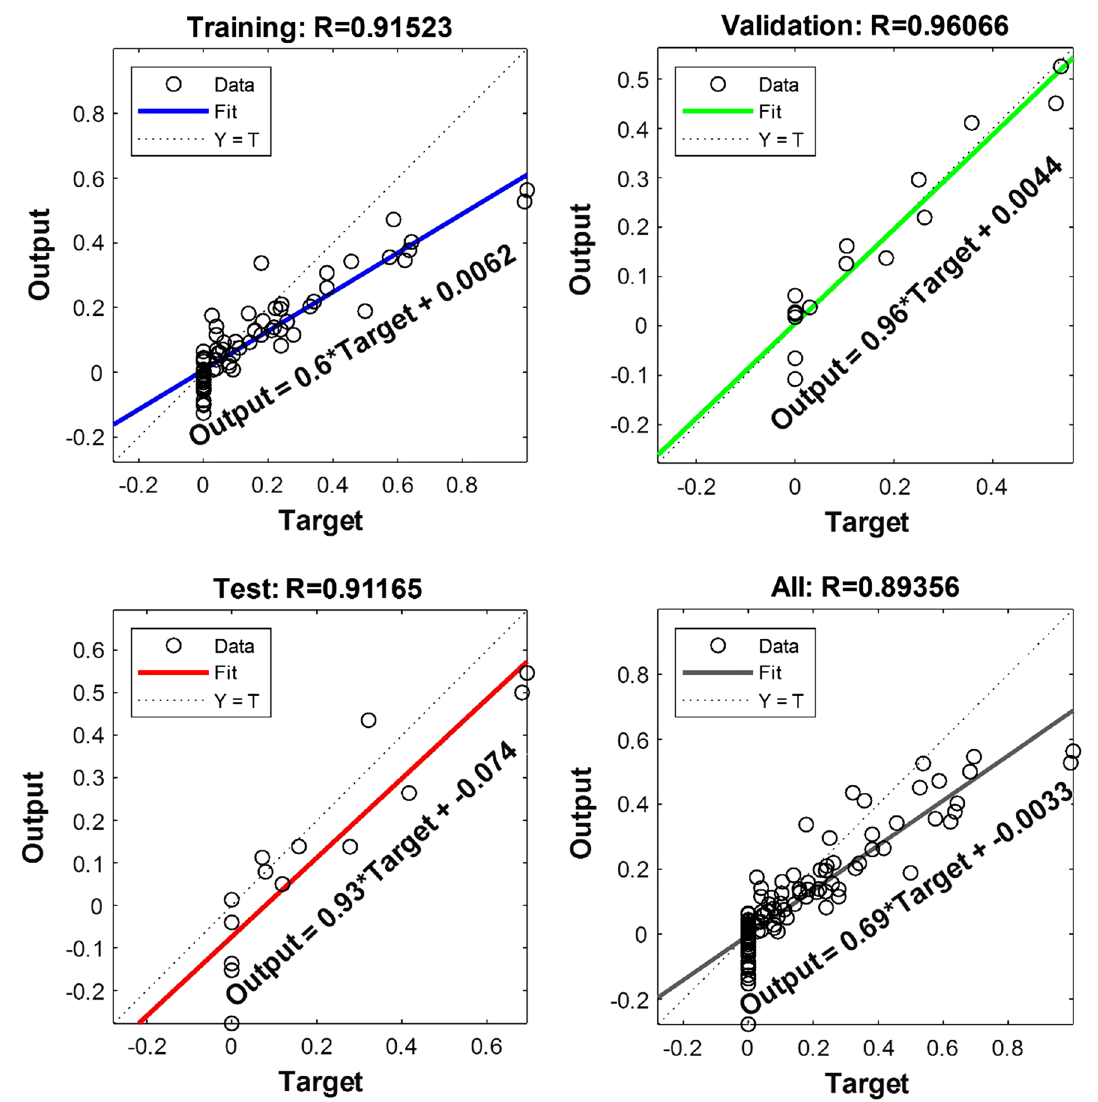
Fig. 24 The training regression of Model No.3 (ANN 3) for liquefaction